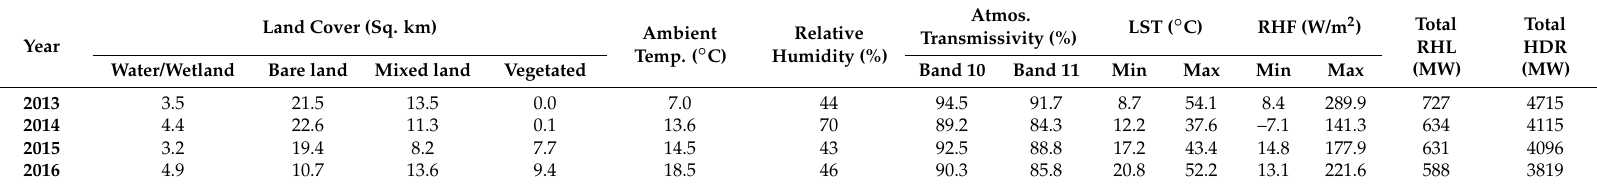
Table 1. Summary of the results of the